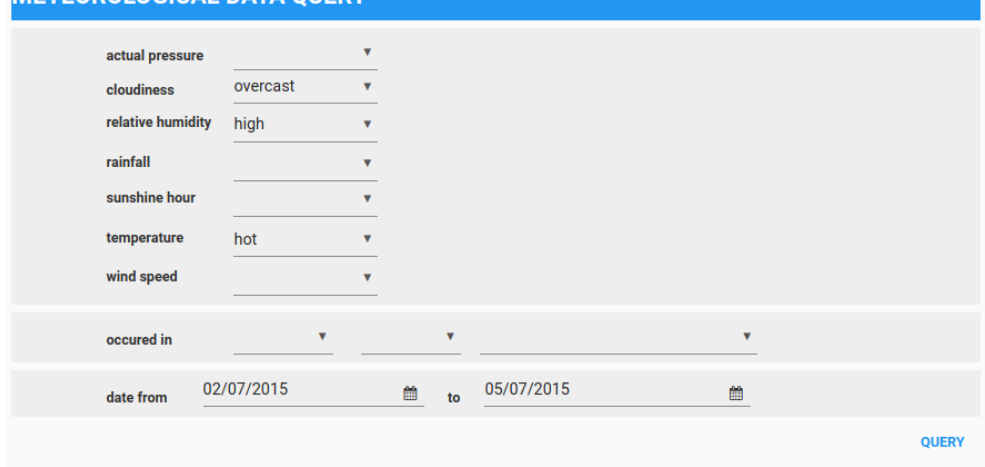
Figure 7. Meteorological data query UI.